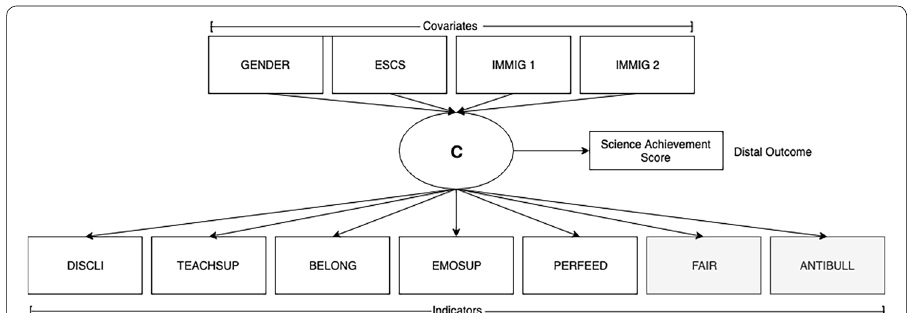
Fig. 1 Full latent profile model with the indicators of perceived school climate, covariates, and the science achievement score as the distal outcome. C categorical latent variable indicating the